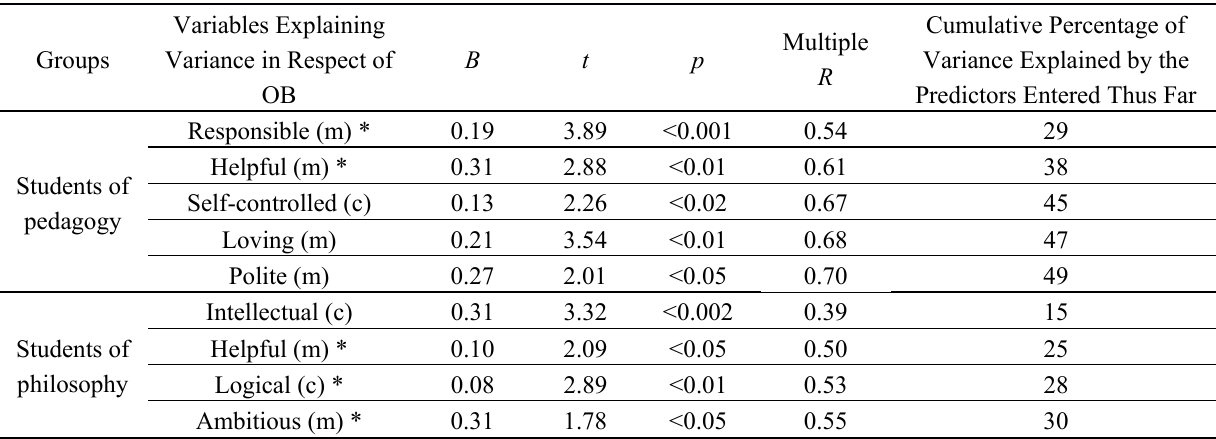
Table 1. Independent variables relating to instrumental values with a moral (m) and a competence (c) character explaining variance, in respect of experiences of God’s presence (OB), in groups of students of pedagogy and students of